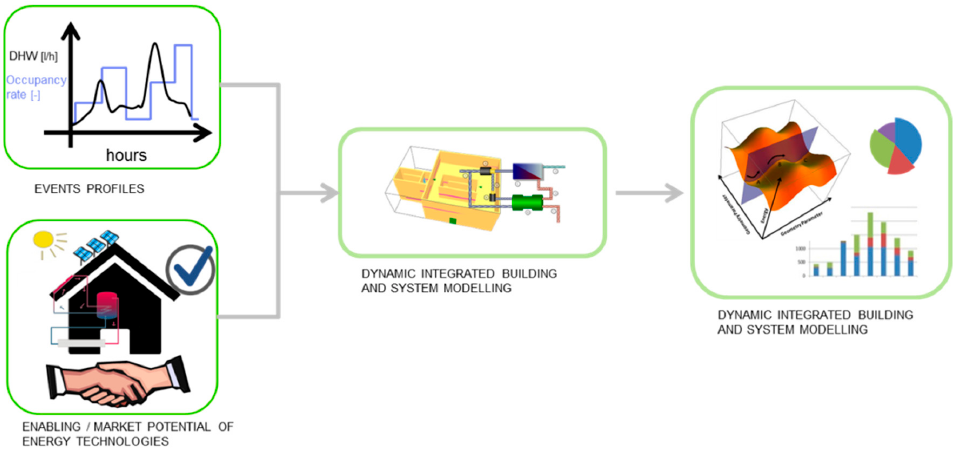
Figure 5. Building energy consumption assessment procedure [28].